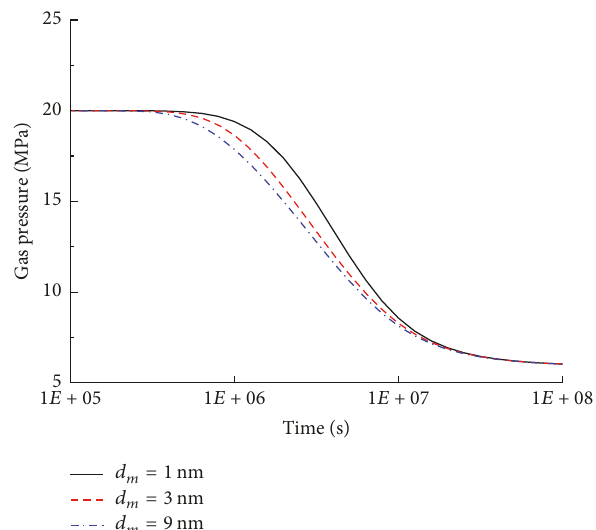
Figure 17: Gas pressures in matrix at different pore sizes.